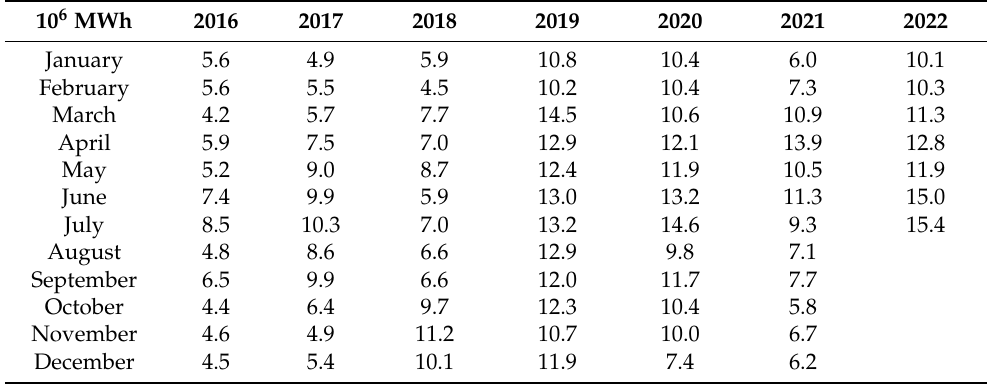
Table 5. Flow from Terminal LNG.